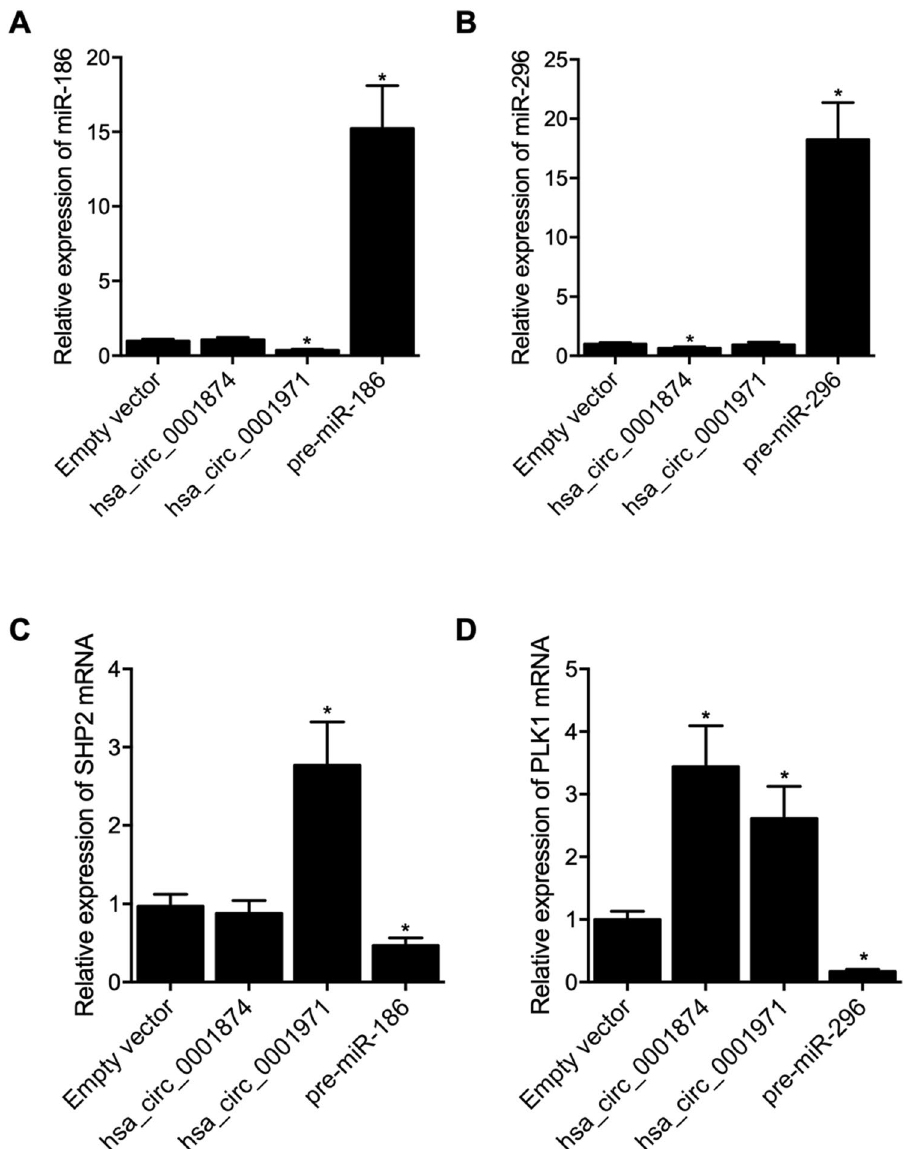
Figure 4. The overexpression of hsa_circ_0001874 and hsa_circ_0001971, as well the overexpression of miR-186 and miR-296, exhibited different effects upon the gene expression of PLK1 and SHP2. ( A ) Relative expression of miR-186 was evidently suppressed in the hsa_circ_0001971 group rather than in the hsa_ circ_0001874 group. The successful transfection of miR-186 precursors was validated by evidently up-regulated miR-186 expression (*P value < 0.05 vs. empty vector group); ( B ) Relative expression of miR-296 was evidently suppressed in the hsa_circ_0001874 group rather than in the hsa_circ_0001971 group. The successful transfection of miR-296 precursors was validated by evidently up-regulated miR-296 expression (*P value < 0.05 vs. empty vector group); ( C ) Relative expression of SHP2 mRNA was significantly increased in the hsa_ circ_0001971 group rather than in the hsa_circ_0001874 group. The overexpression of miR-186 significantly down-regulated the relative expression of SHP2 mRNA (*P value < 0.05 vs. empty vector group); ( D ) Relative expression of PLK1 mRNA was significantly higher in both hsa_circ_0001874 and hsa_circ_0001971 groups. The overexpression of miR-296 significantly down-regulated the relative expression of PLK1 mRNA (*P value < 0.05 vs. empty vector